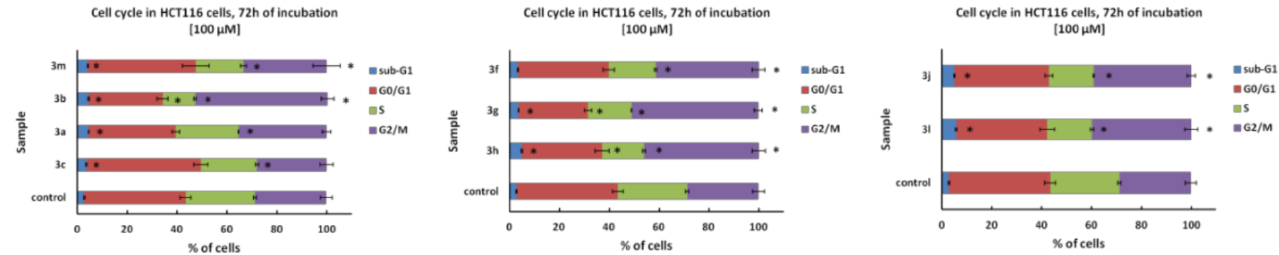
Figure 6. Cell cycle in HCT116 cells after a 72 h incubation with compounds with the concentration of 100 µ M. The results were presented as mean value ± SD. The statistical analysis was based on a t-test, and a p -value less than 0.05 was considered statistically significant in comparison to the untreated controls Table 3 (indicated with a star). Table 3. The comparison of the cytotoxic effects of 3a – 3c, 3f – 3h, 3j, 3l and 3m derivatives against MCF-7, HCT116, and HeLa cell lines.